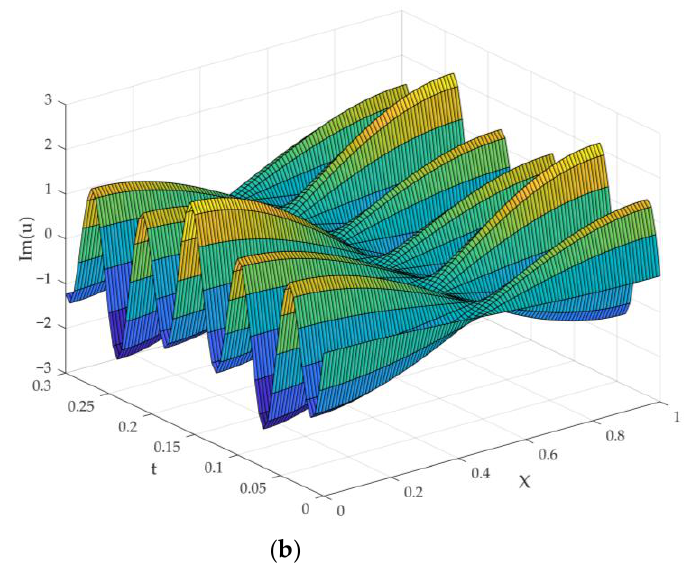
Figure 8. The evolvement of lateral displacement: ( a ) the real-part; ( b ) the imaginary-part.